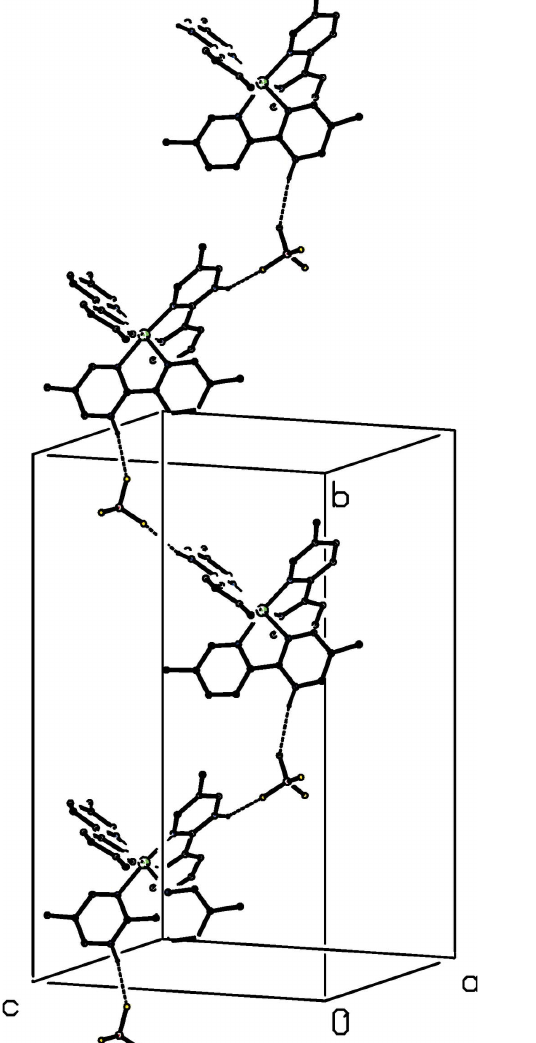
Figure 11 Part of the crystal structure of compound (IV) showing the formation of a hydrogen-bonded C 2 (12) chain running parallel to the [010] direction. 2 For the sake of clarity, the tcnoet anion and the H atoms not involved in the motif shown have been omitted.